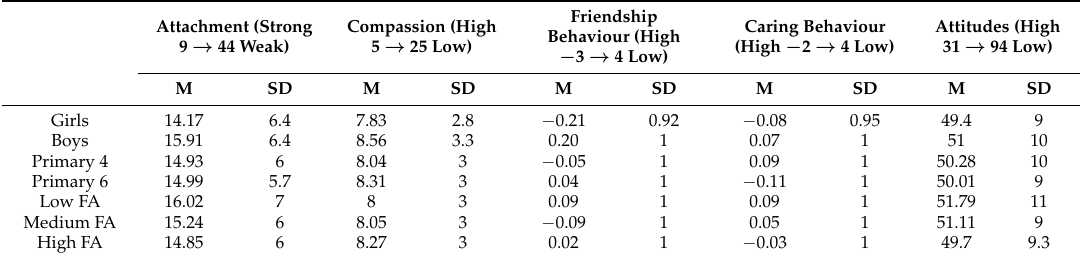
Table 3. Descriptive statistics for socio-demographic variables.